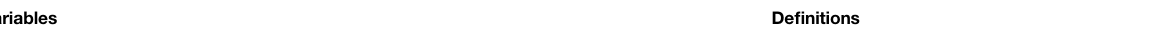
TABLE 1 | Dependent and independent